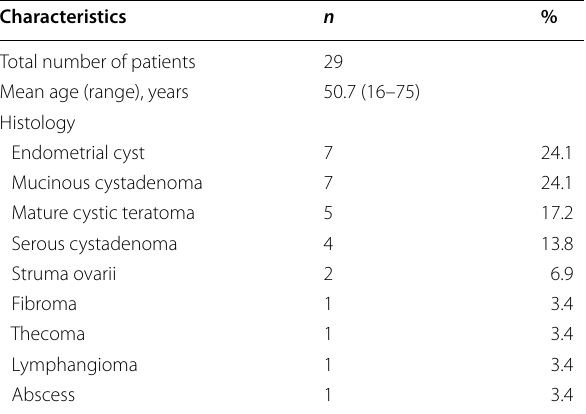
Table 2 Characteristics of patients with pathologically benign ovarian tumor Characteristics